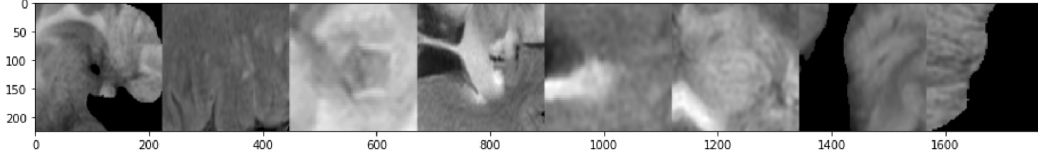
Figure 10. Example of patches extracted from